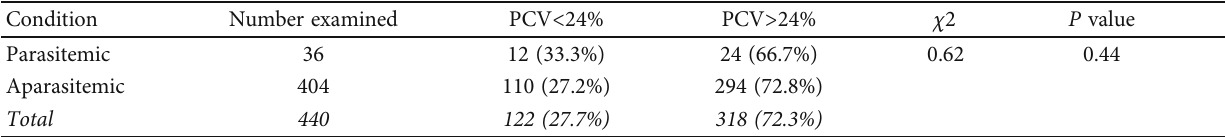
Table 4: Comparison of mean PCV value between parasitemic and aparasitemic